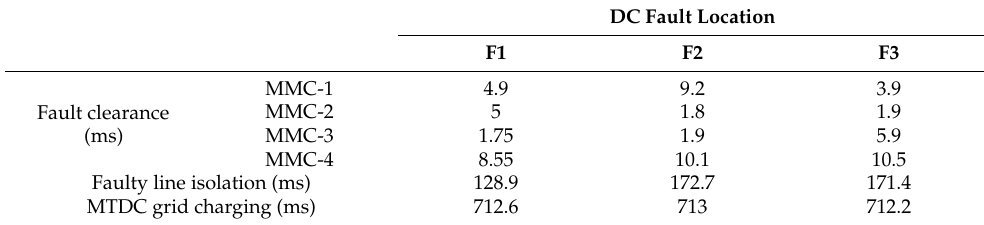
Figure 19. DC currents of the MTDC terminals with DC fault at location F3. Table 3. Fault clearance and restoration time at different fault